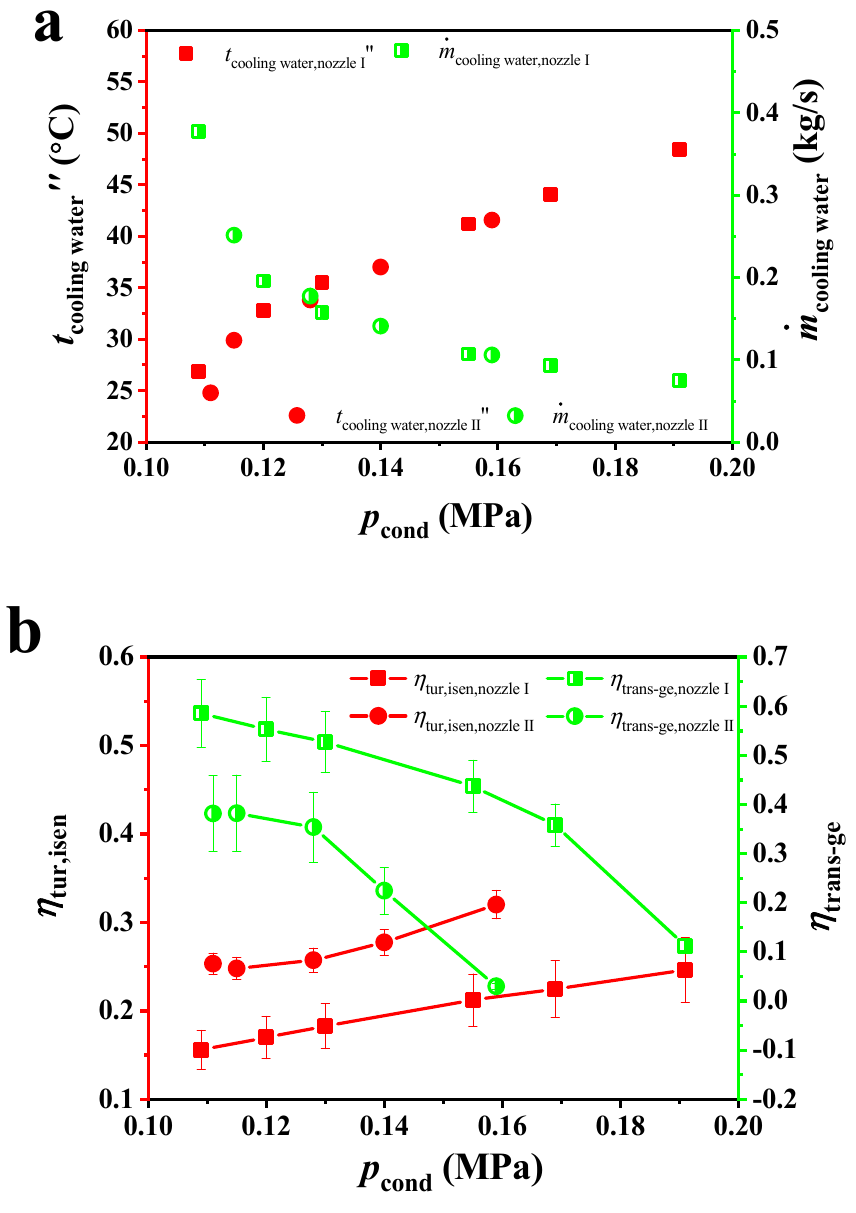
Figure 10. Variation of system performance with condensing pressure (R123). ( a ): Parameters about the cooling water; ( b ): Efficiency about the turbine and the generator